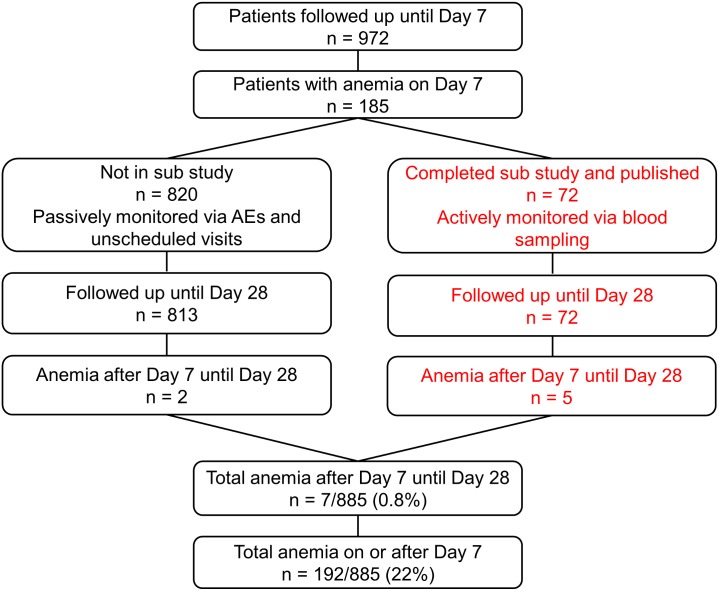
Post hoc analyses of patients with anemia.The right hand side of the diagram (in red) shows patients included in the substudy.